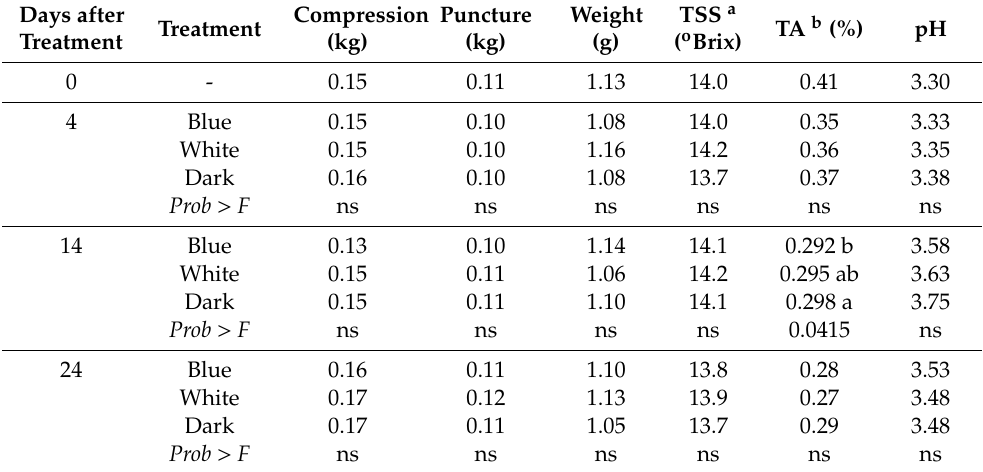
Table 2. Quality attributes of ripe ‘Alapaha’ rabbiteye blueberries subjected to light treatments at various times during cold storage. Days